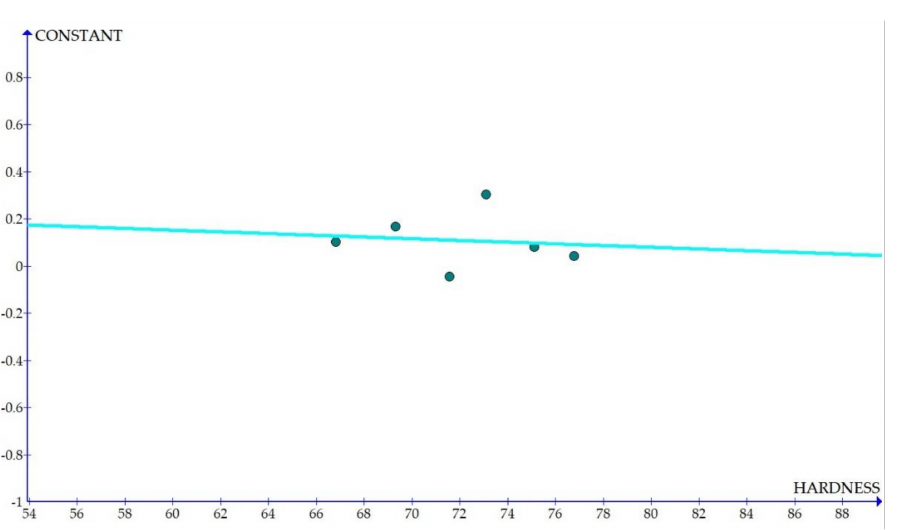
Figure 6. Coefficient of kerf width: current × WFR vs. hardness.